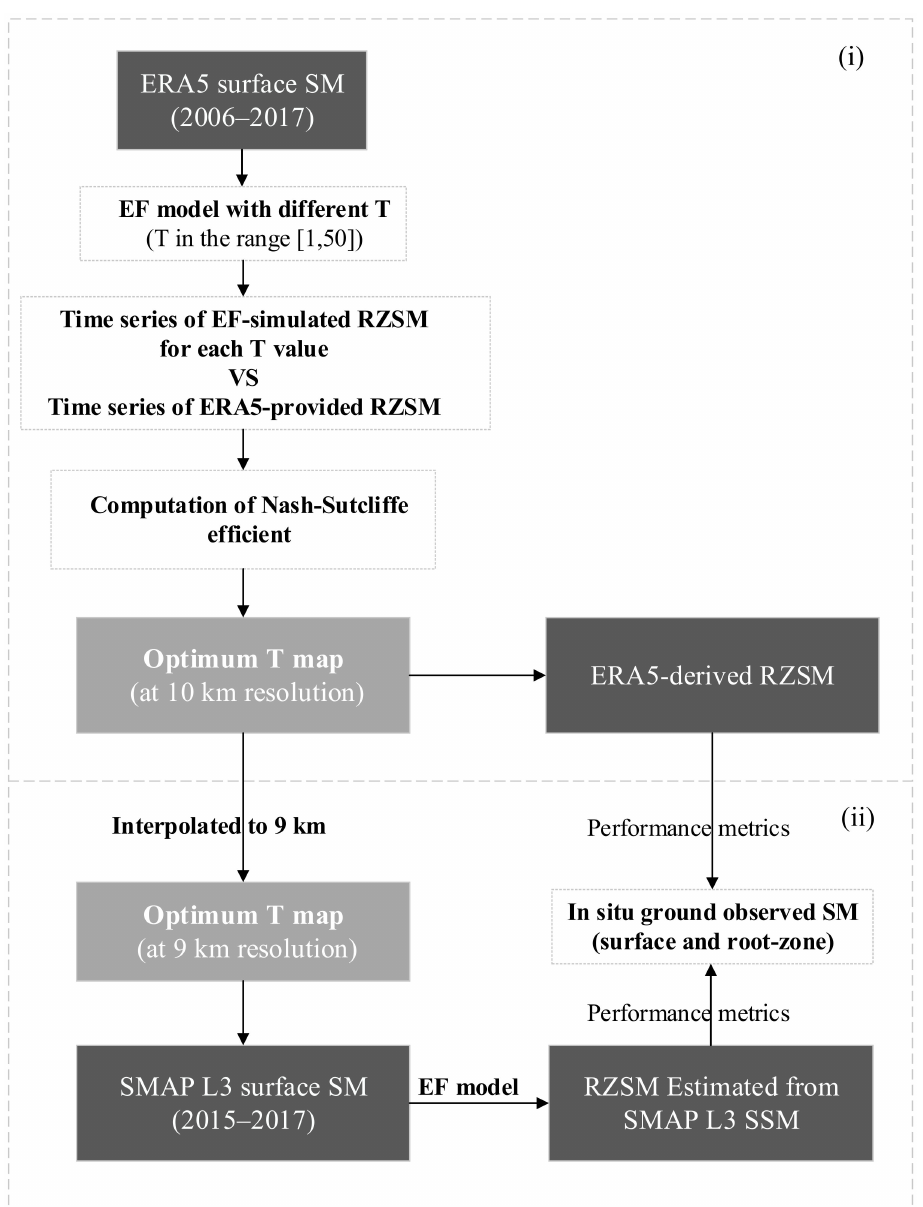
Figure 2. Estimation scheme for calibrating and validating EF models using ERA5 surface and root zone SM datasets (i), and estimating the root zone SM from SMAP L3 surface SM using the established EF model